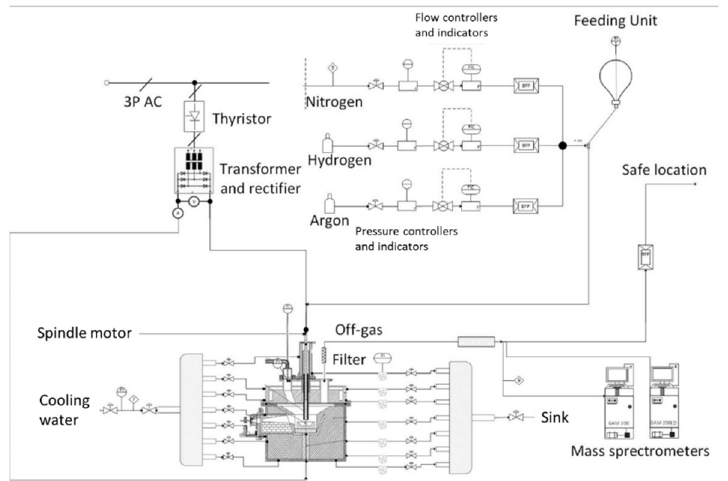
Figure 1. Flowsheet of the HPSR laboratory plant at the Montanuniversitaet in Leoben [12].